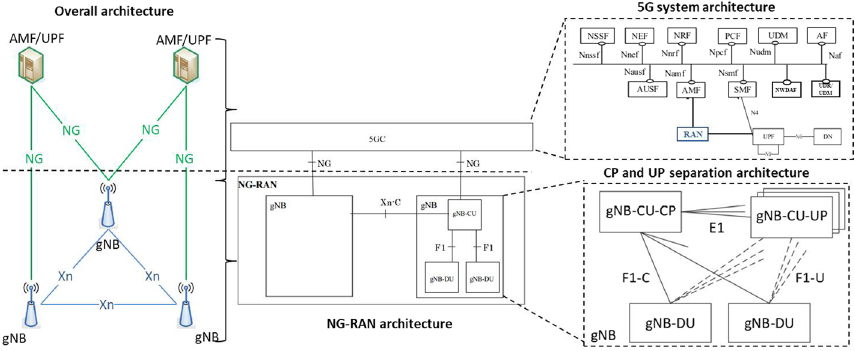
Fig. 1 Generic service-based 5G system and RAN architecture as specified in 3GPP